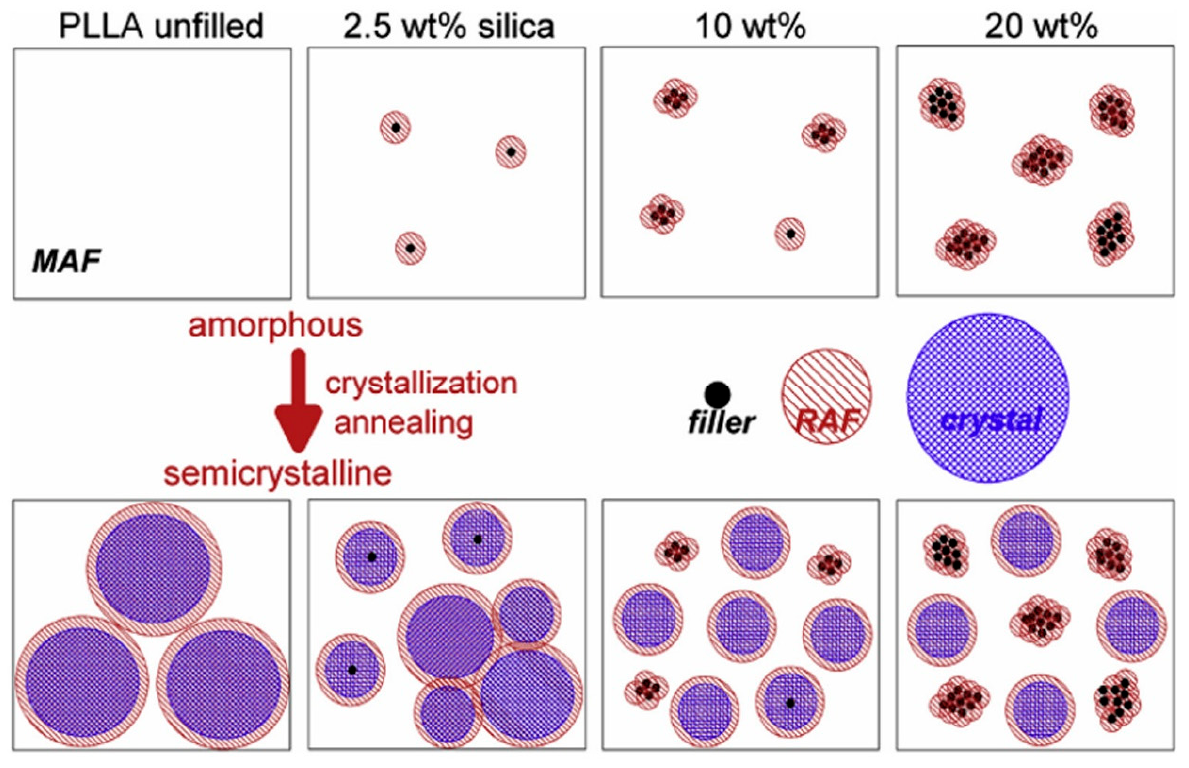
Figure 4. The proposed distribution of the silica in the PLA matrix before and after annealing of crystallization [57].